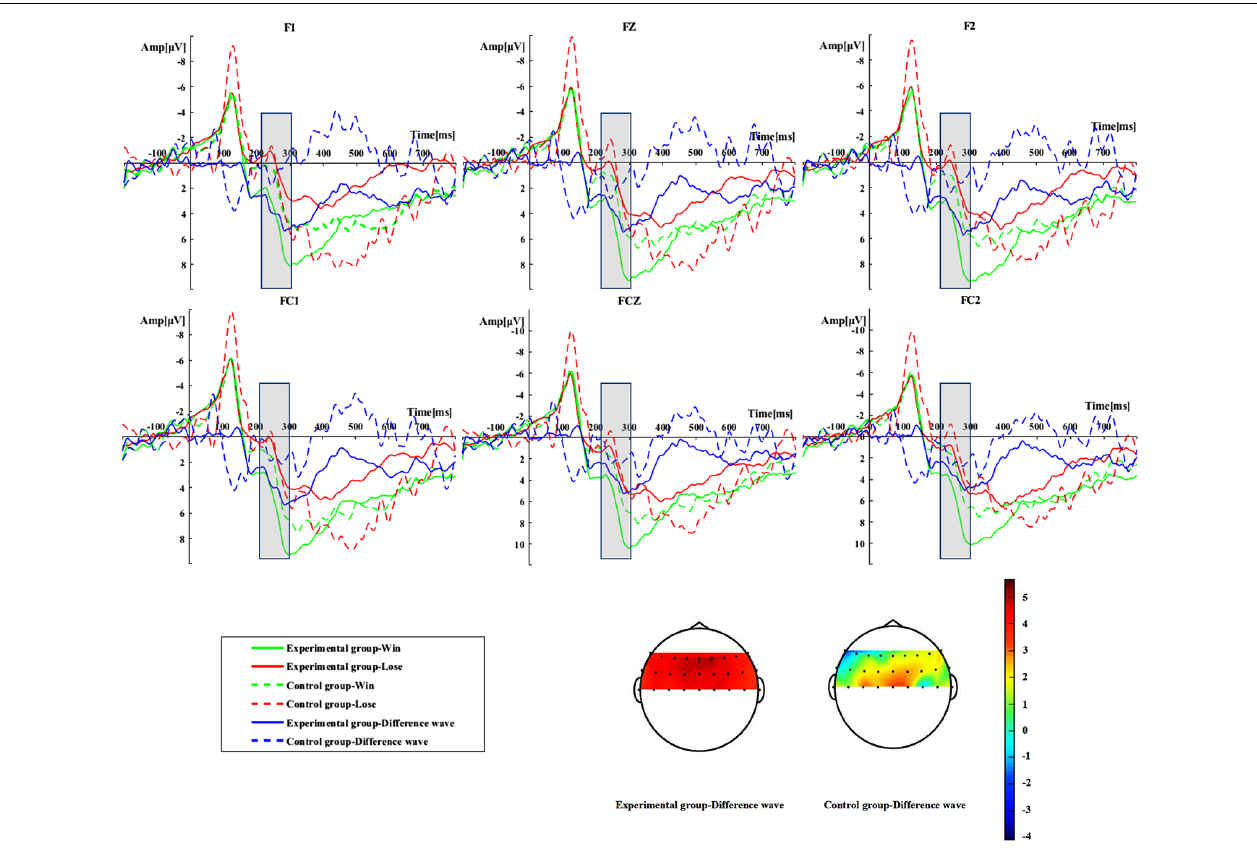
FIGURE 2 | Reward positivity (RewP) results during outcome evaluation. Grand-averaged event-related potential (ERP) waveforms of RewP and its win–lose difference wave from the electrodes of F1, Fz, F2, FC1, FCz, and FC2 were shown for the group (experimental group vs. control group) and outcome (win vs. loss) conditions. The scalp topographic distribution of the win–lose difference wave of RewP is plotted for the recorded electrodes, and the bar ranges from − 4 to 5 µ